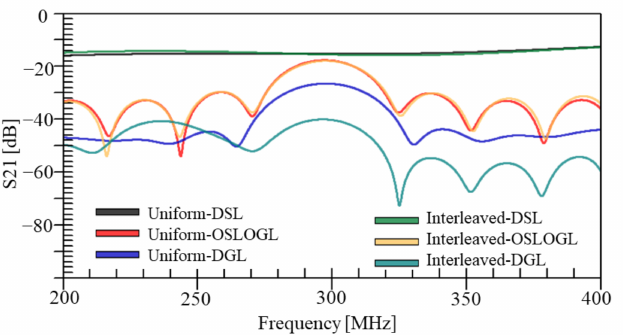
Figure 4. The S21 parameters reflecting the coupling between two microstrips for different